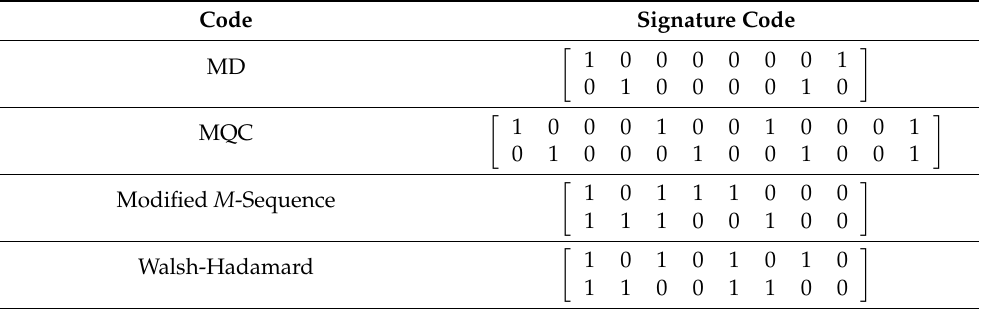
Table 4. Signature codes for two